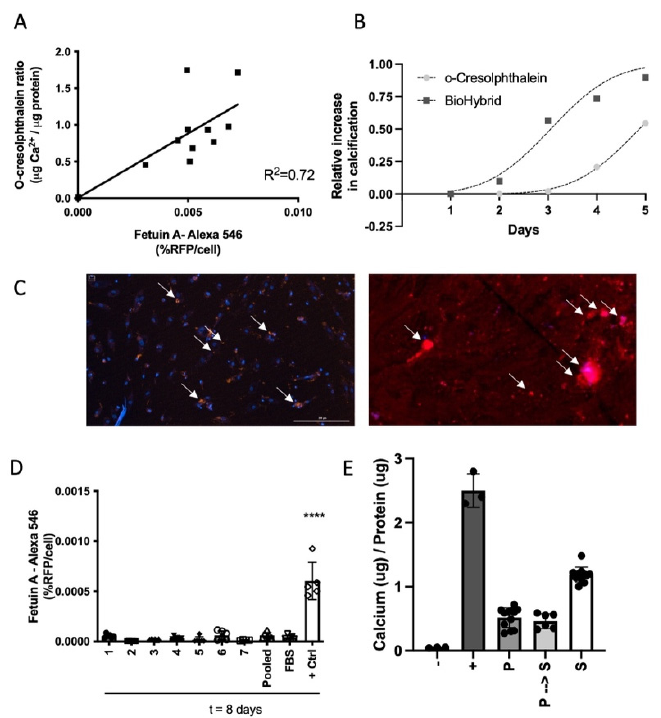
Figure 1. BioHybrid calcification assay. ( A ) Live calcification assay compared to the o-Cresolphthalein method provides a good correlation, R 2 = 0.72. ( B ) Relative increase in calcification of both BioHybrid and o-Cresolphthalein methods. ( C ) Representative images (4 × magnification) of the BioHybrid calcification assay for minimal and severe calcification. ( D ) Calcification assay comparing FBS to serum of healthy individuals (nr. 1–7) and control serum from healthy donors (pooled; n = 7). ( E ) Calcification of control plasma vs. serum (P = plasma ( n = 4); P → S = recalcified plasma ( n = 4); S = Serum ( n = 4)). Positive controls are always under 0.5% serum conditions. **** p < 0.0001 .